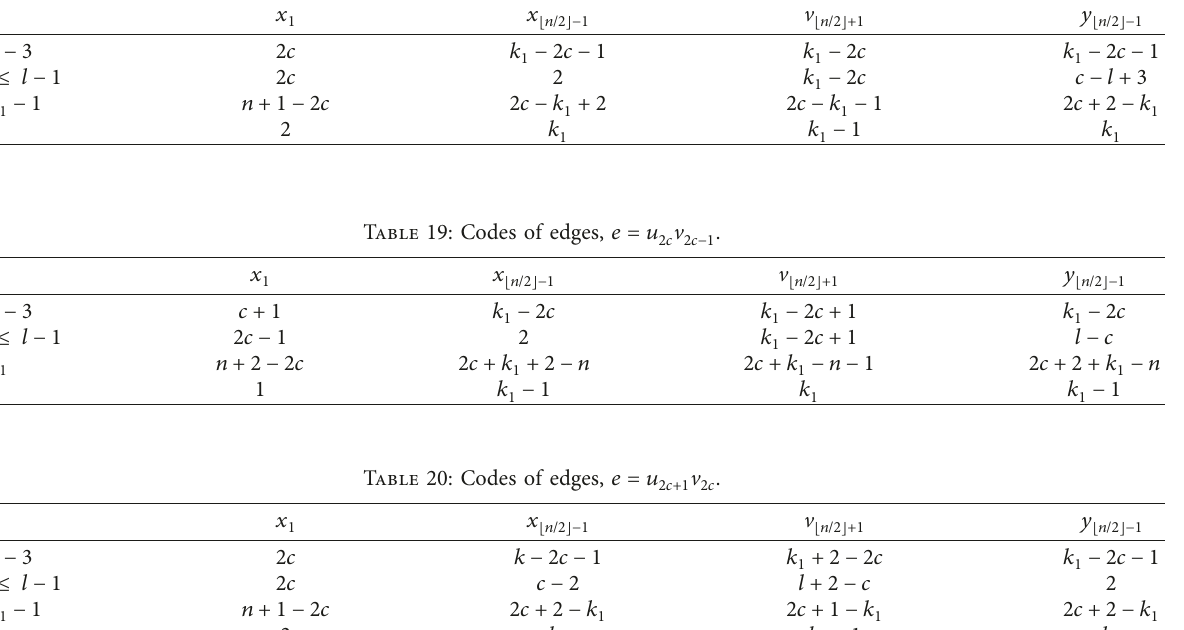
Table 21: Codes of edges, e � x